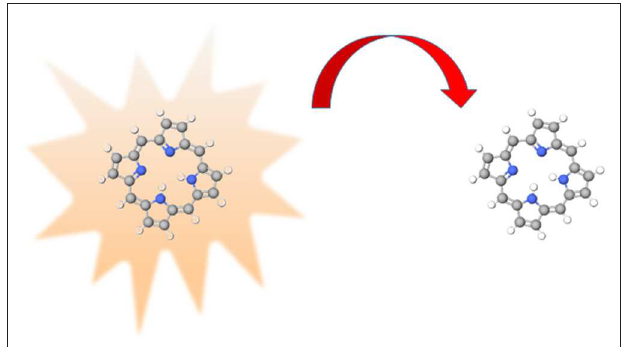
FIGURE 1 | Representation of energy transfer, the excited donor (on the left-hand side) transfers energy, represented by the red arrow, to the acceptor (on the